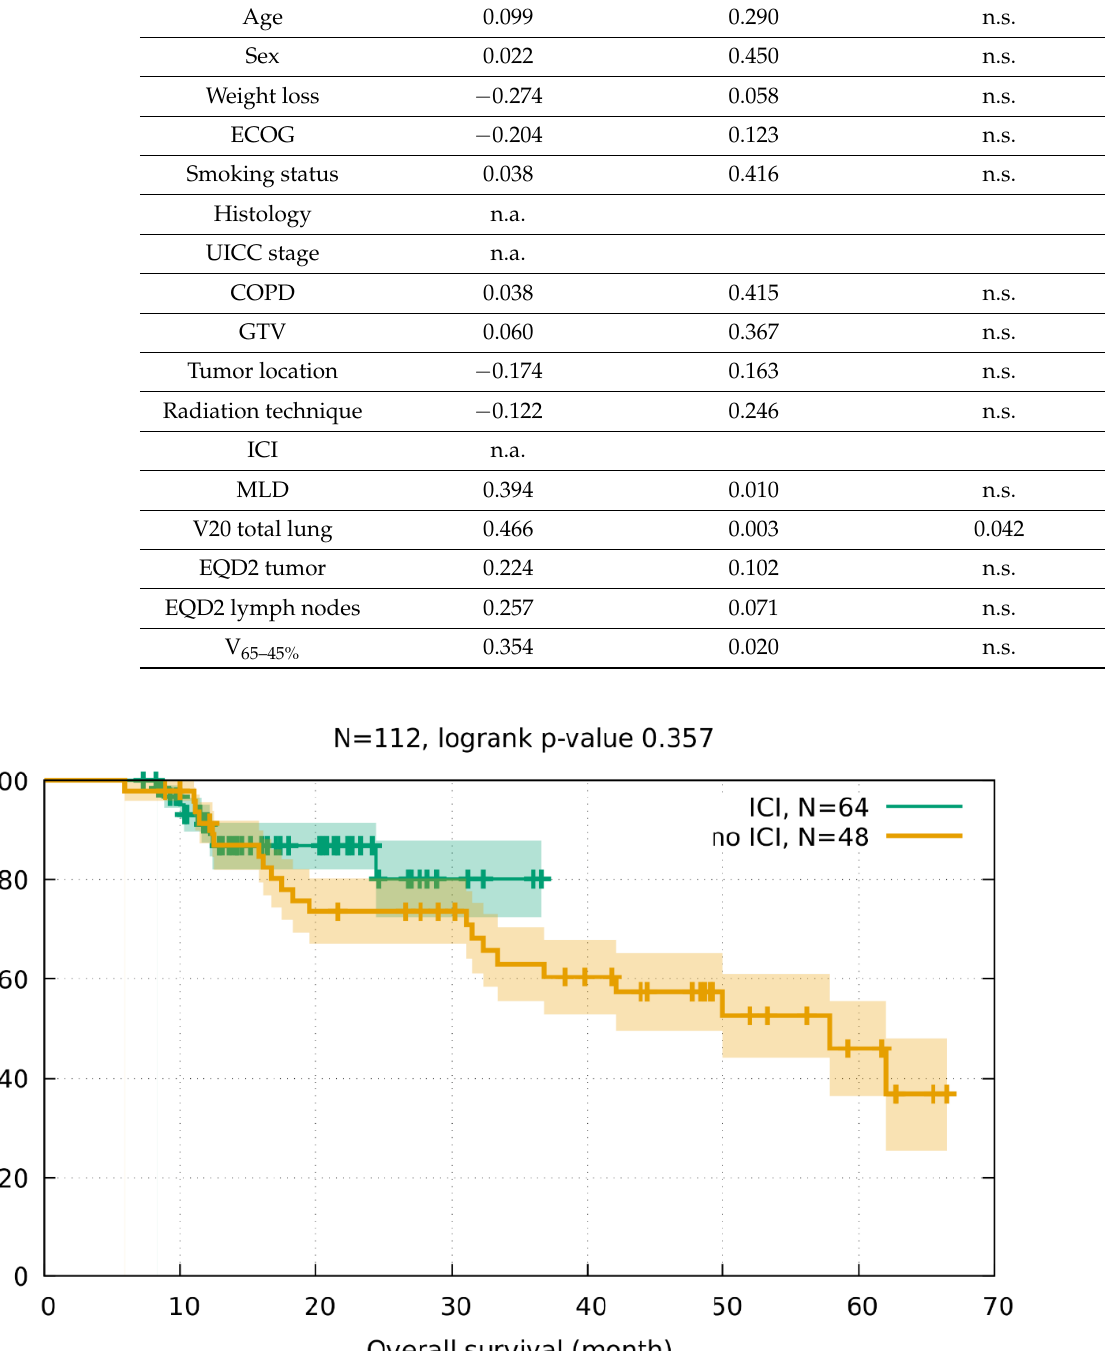
Figure A2. The comparison between subgroups revealed a significantly better progression-free sur- vival for patients with immunotherapy (logrank p -value = 0.003).